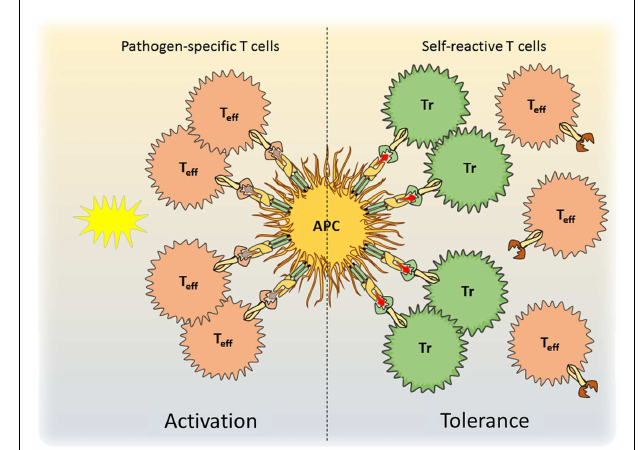
FIGURE 1 |A model for antigen-specific function ofTregs during infection is shown . During pathogen encounter, activated antigen- presenting cells present both self- and pathogen-derived antigens to CD4 + T cells.Whereas pathogen-specific effectorT cells are activated (left), competition for access to antigen withTreg cells prevents the activation of autoreactive effectorT cells and maintains self-tolerance